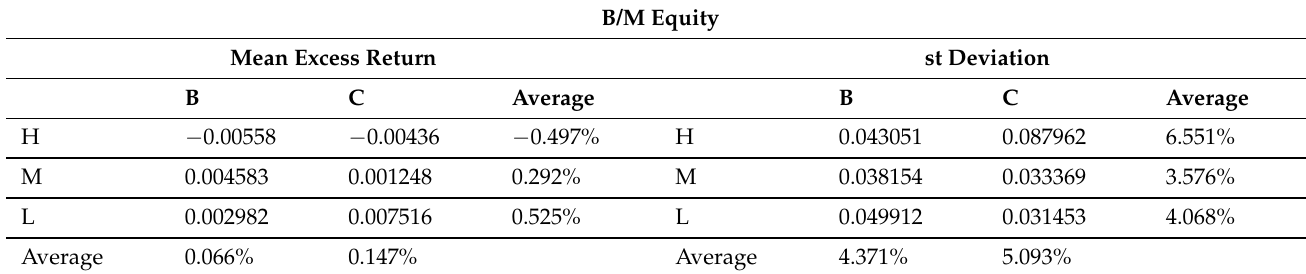
Table 3. The average excess returns per month for portfolios built by using size and BE/BE.